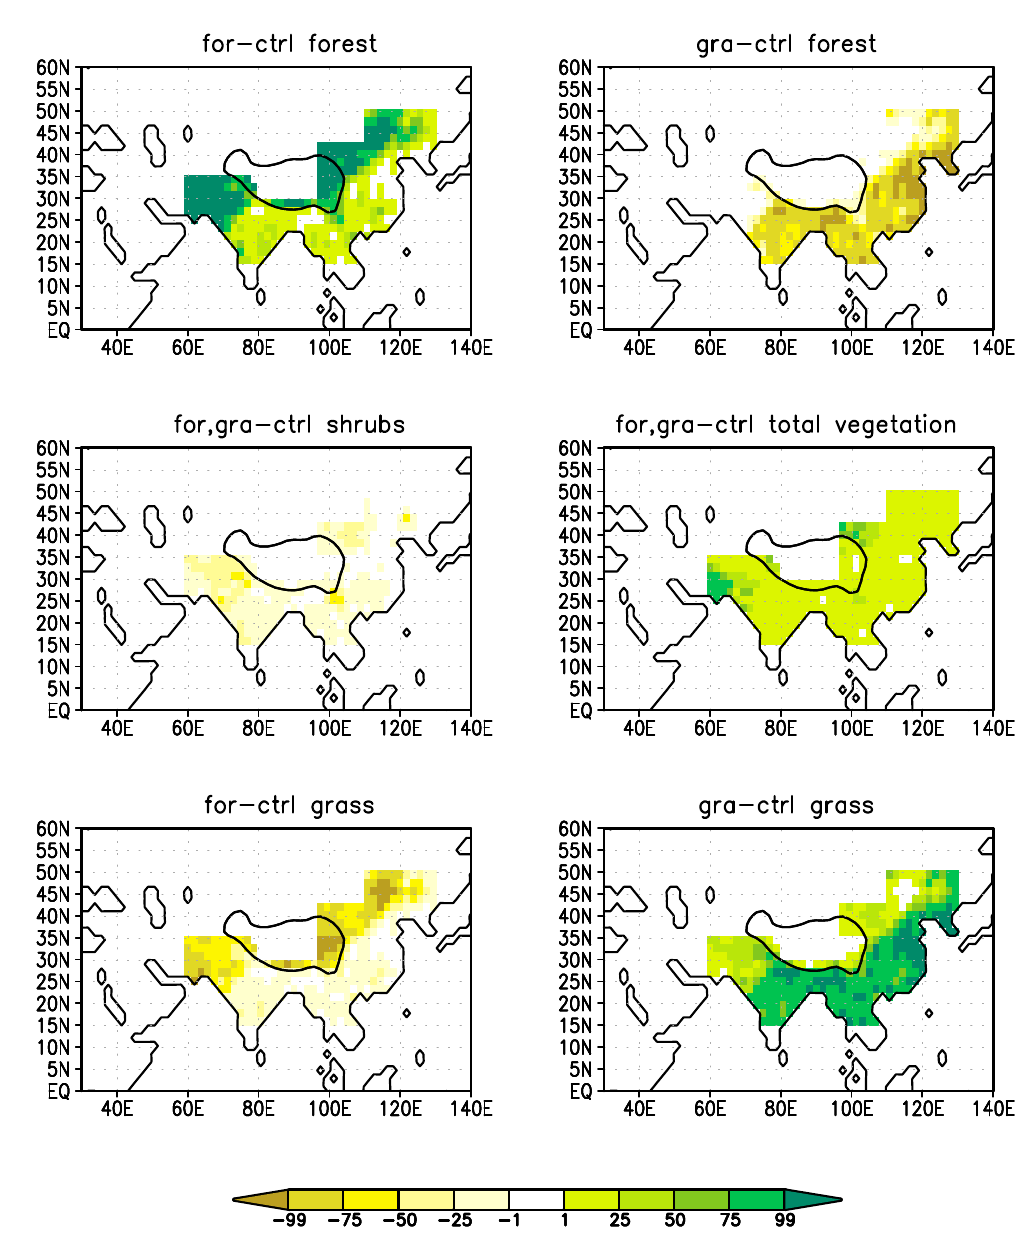
Fig. 2. Differences in forest, shrubs, grass and total vegetation distribution between the land cover map prescribed in the afforestation experiment (for) or the deforestation experiment (gra) and the control run (ctrl). Values are given in fraction per